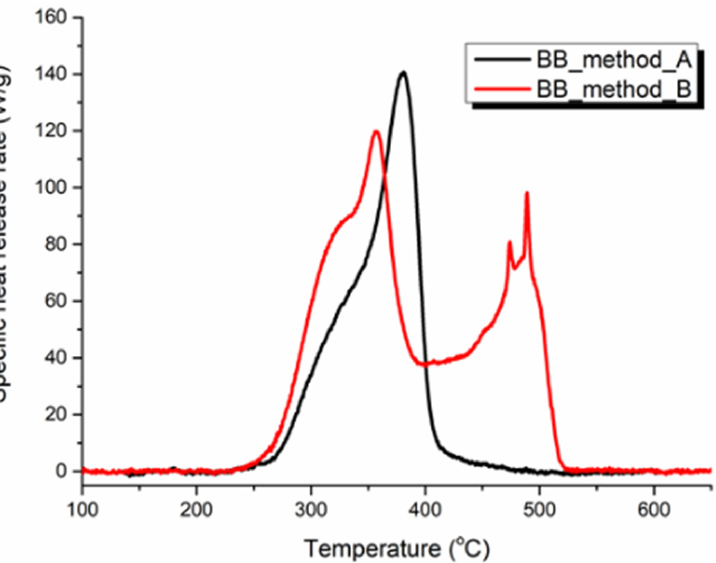
Figure 4. Comparison of specific heat release rate curve of BB sample with 1 K s − 1 heating rate for Method A (black solid line) and Method B (red solid line).